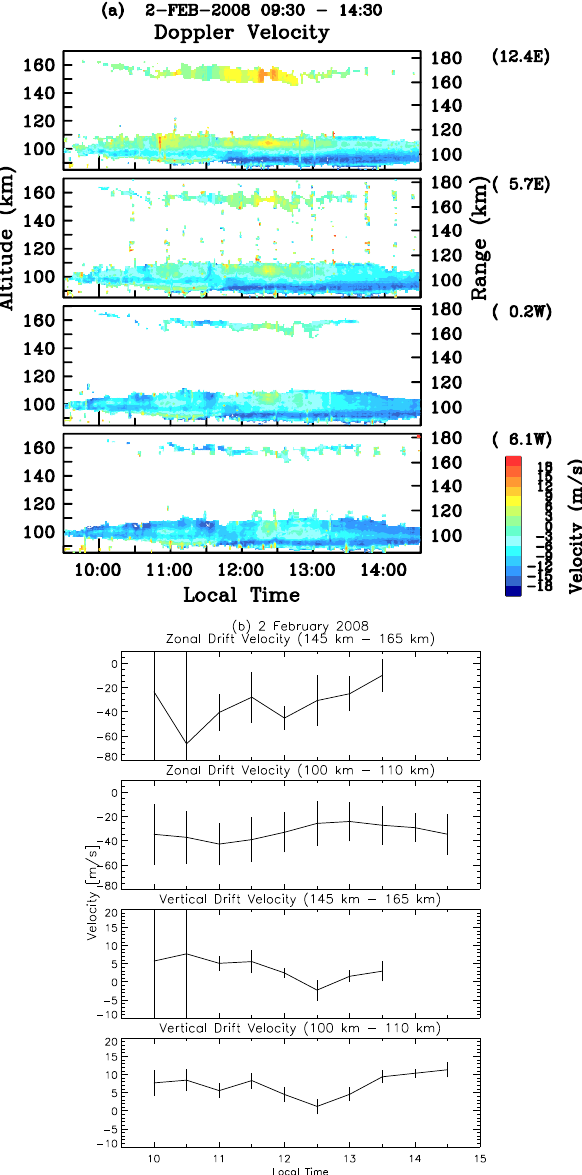
Fig. 4. (a) RTI plots of Doppler velocity of the backscatter echoes obtained by the high resolution mode on 2 February 2008. Positive (negative) Doppler velocity indicates a line-of-sight motion toward (away from) the EAR. (b) Zonal and vertical drift velocities of 150-km and upper E -region echoes derived by the least-square method. Vertical bars represent standard deviation.